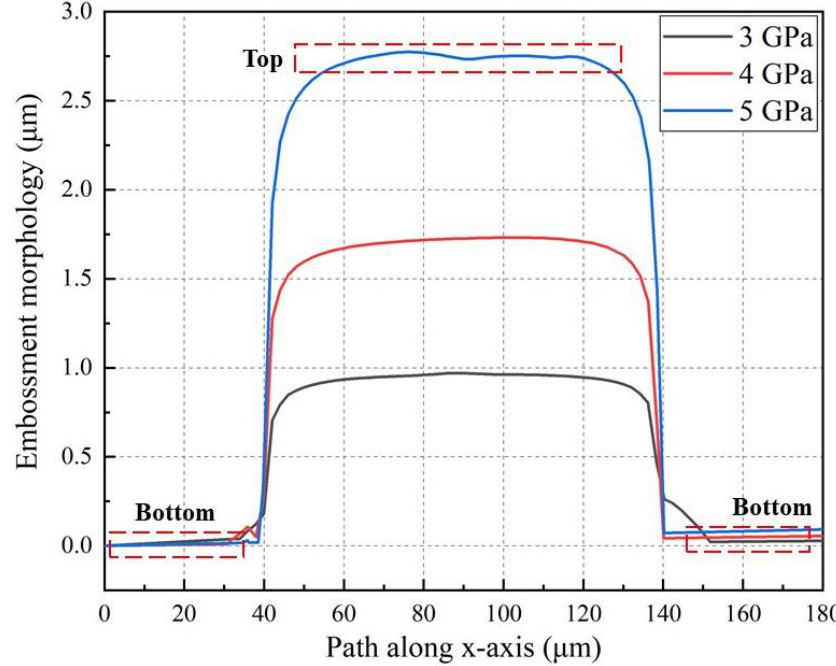
Figure 4. Profile of the embossments at different peak pressures.